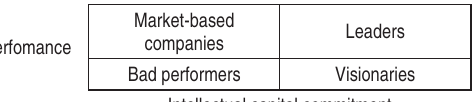
Fig. 1. Positioning